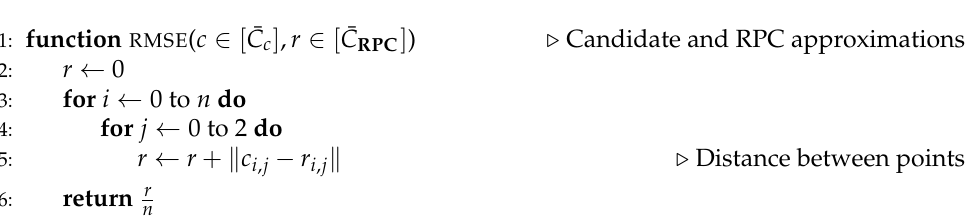
Algorithm 2 Calculates the RMSE between two sets of triangles which approximate the point